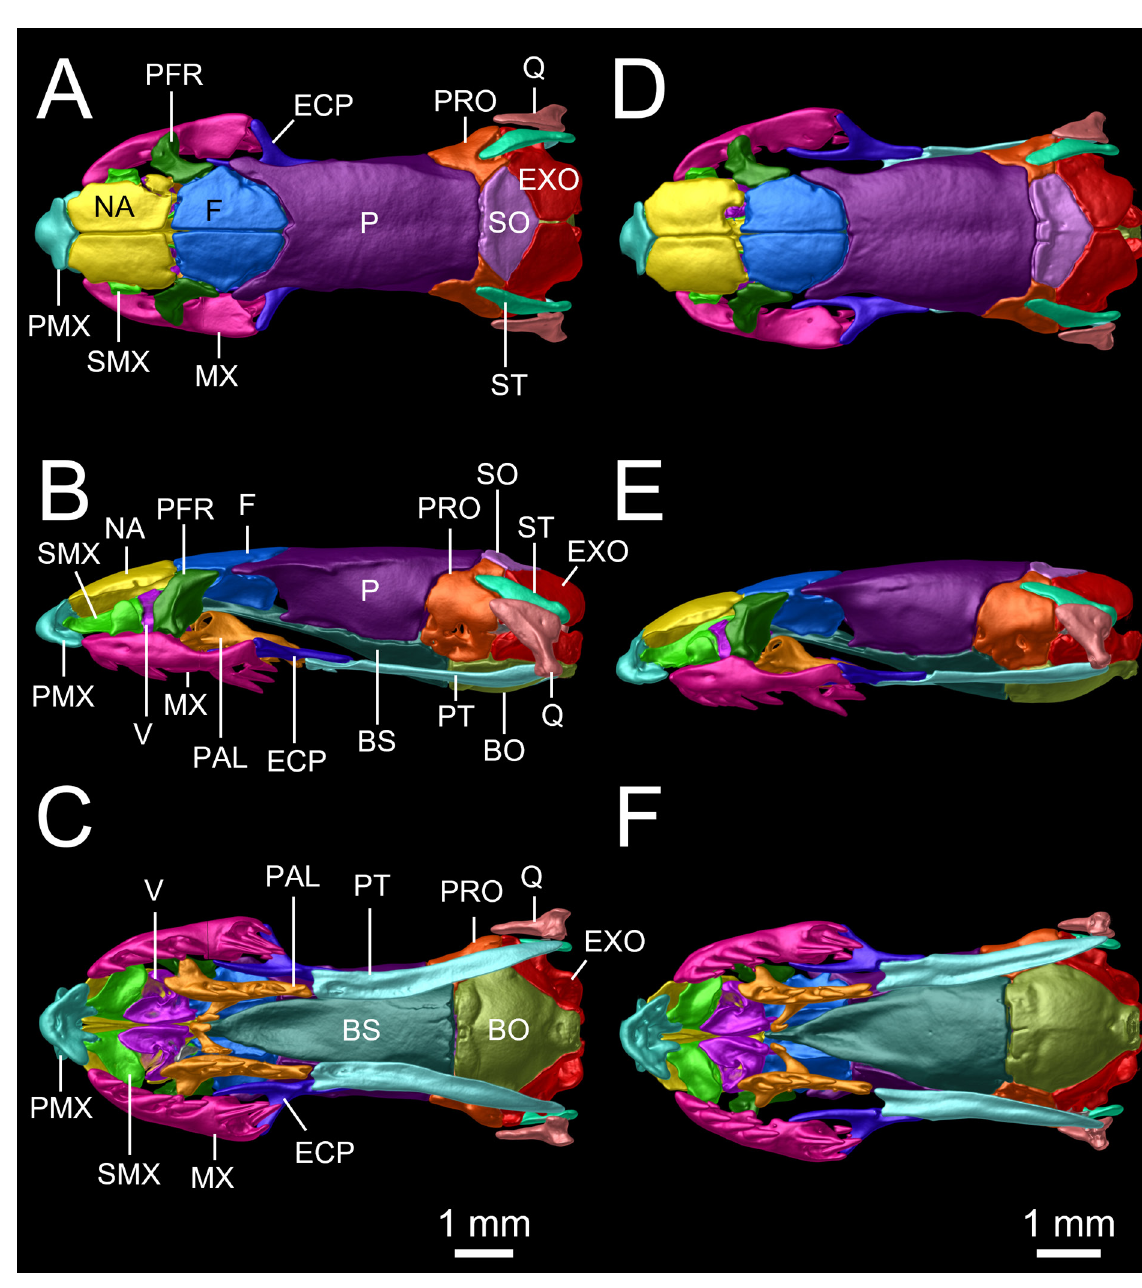
Fig. 9. Dorsal (A, D), lateral (B, E), and ventral (C, F) views of the skull based on μCT imagery. A–C . Apostolepis albicollaris Lema, 2002, holotype (MCP 8355). D–F . A. cerradoensis Lema, 2003, holotype (MCP 15219). Different skull elements are digitally colored and the mandible is removed for better visualization. Abbreviations: BO = basioccipital; BS = basisphenoid; ECP = ectopterygoid; EXO = exoccipital; F = frontal; MX = maxilla; NA = nasal; P = parietal; PAL = palatine; PFR = prefrontal; PMX = premaxilla; PRO = prootic; PT = pterygoid; Q = quadrate; SMX = septomaxilla; SO = supraoccipital; ST = supratemporal; V =